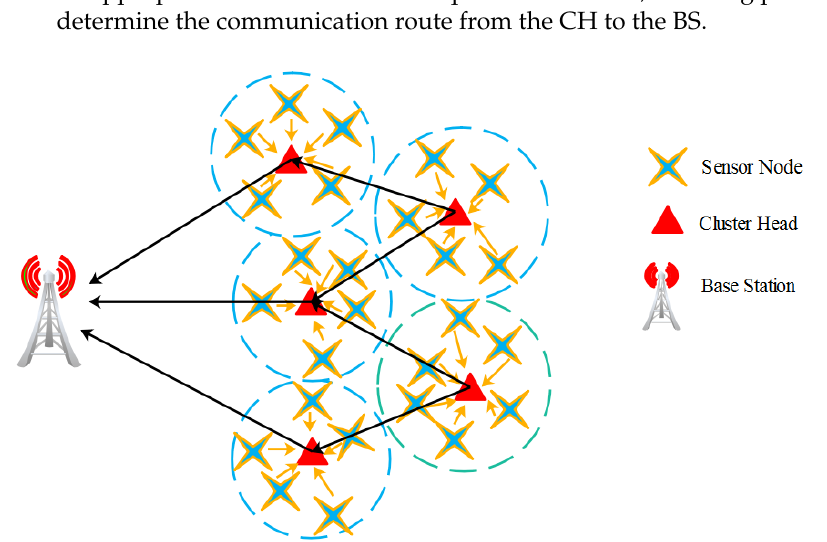
Figure 1. Organization of cluster-based WSN.